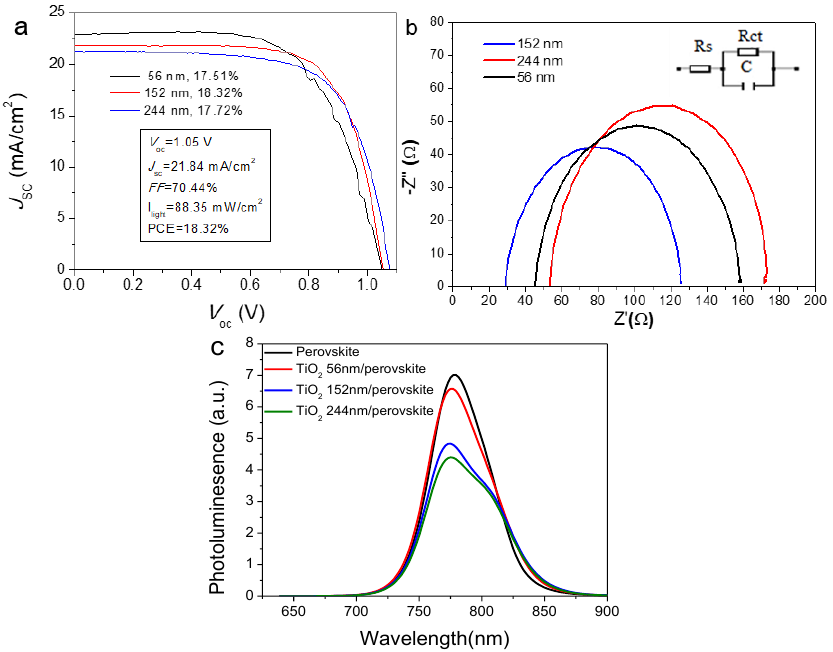
Figure 3. ( a ) J-V curves, ( b ) electrical impedance spectroscopy (EIS) curves of the assembled perovskite solar cells, and ( c ) PL spectra of MAPbI 3 perovskite on bare and TiO 2 deposited glass substrate with various thicknesses of 56, 152, and 244 nm.